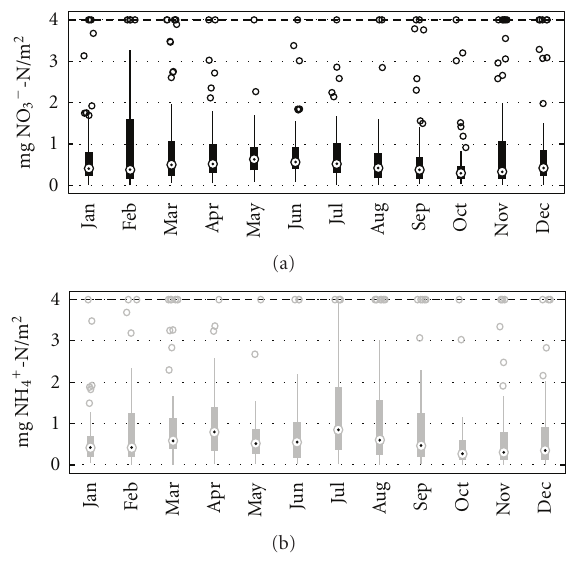
Figure 8: Monthly distribution of nitrogen wet deposition through nitrate (a) and ammonium (b). Black dots show the median; boxes show 25th–75th percentile; lines extend to most extreme data points that are not outliers; empty circles show outliers; outliers are defined as data points, that are 1 . 5 × ( P 75 − P 25 ) above P 75 or below P 25 , where P P 25 and 75 are the 25th and 75th percentile. Outliers were set to 4mg N/m 2